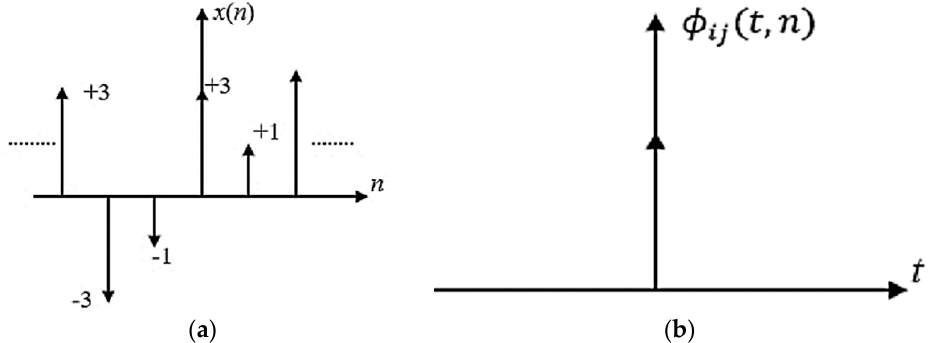
Figure 7. The input signal and its autocorrelation: ( a ) the input signal x ( n ) to the digital LPF and ( b ) the autocorrelation φ ij ( t , n ) of the input signal x ( n ) with i = j , where φ ij ( t , n ) = x i ( n ) x j ( n ) , with i , j = 1,2, ··· , N − 1, t = (cid:12) i − j (cid:12) .